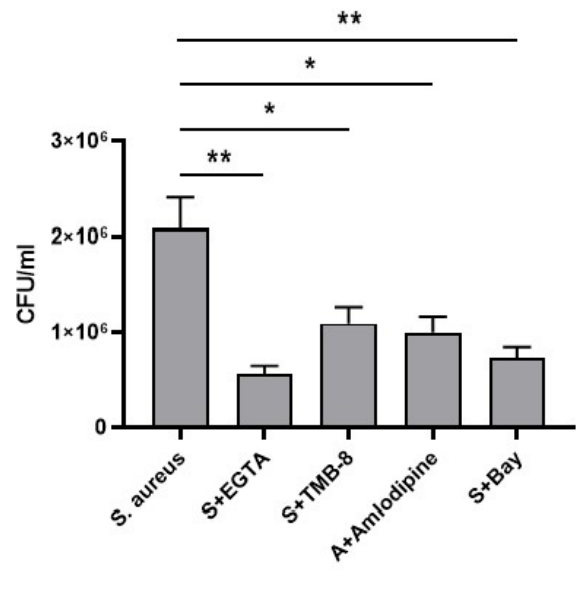
Figure 5: Calcium differentially regulates S. aureus survival in macrophages. Murine J774 macrophages were incubated with either EGTA or TMB-8 or amlodipine or BAYK8664 for 2h followed by 20 MOI S. aureus infection for 24h. After incubation, cells were lysed with 10% SDS and serial dilutions were plated on nutrient agar plates and scored for CFUs. Data represent mean ± SD of three independent experiments for each group. P value between group S. aureus vs S. aureus + EGTA is p=0.0023; S. aureus vs S. aureus + TMB-8 is p=0.0155, S. aureus vs S. aureus + Amlodipine is p=0.0104 and S. aureus vs S. aureus + BAYK8664 is